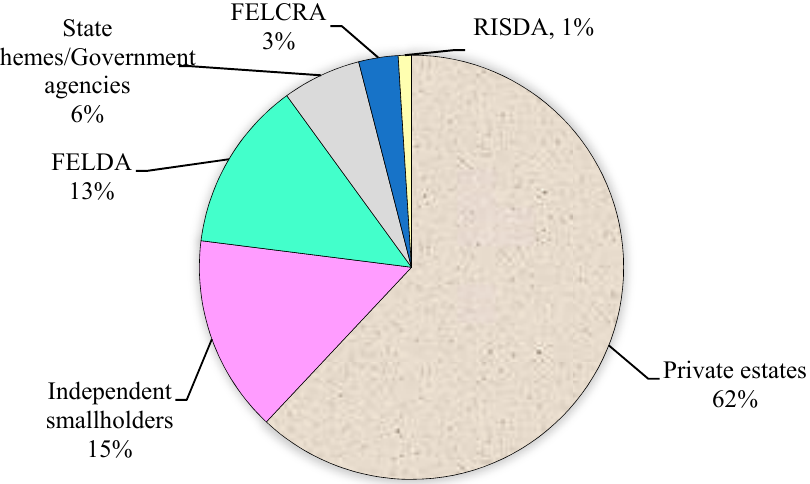
Figure 2. Percentage of plantation ownership of oil palm in Malaysia [12]. Reprinted with permission from Elsevier [12].